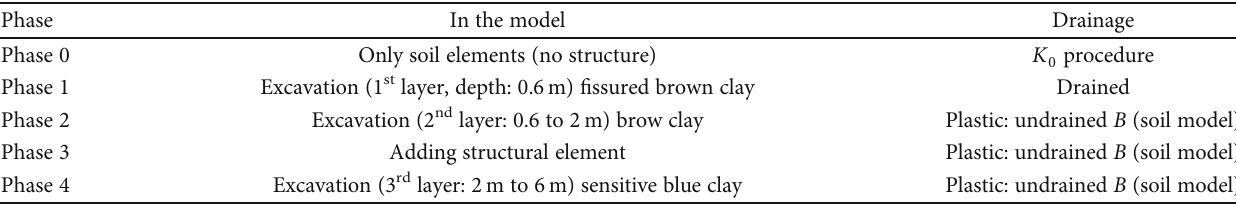
Table 5: Construction sequence of FE modelling in